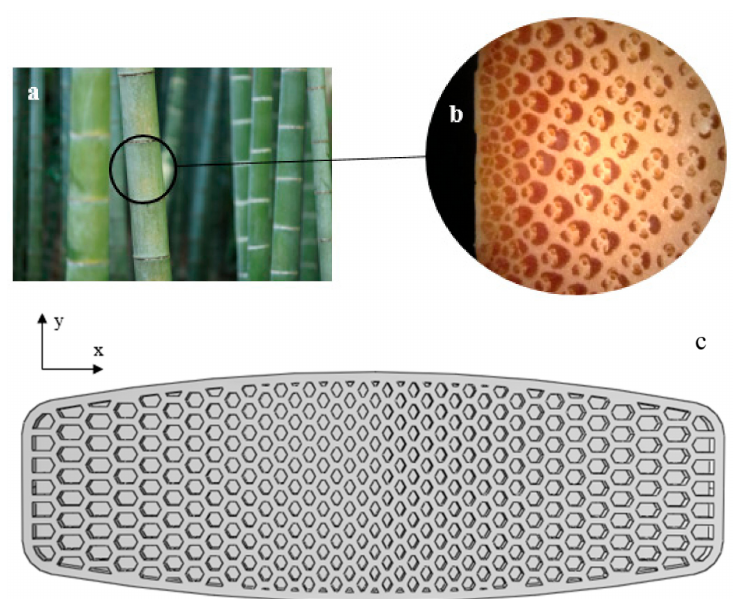
Figure 20. ( a ) A Bamboo stalk; ( b ) An optical image of the FG bamboo cross-section in which the dark areas are the fibers, while the light areas are the parenchyma matrices (adapted from [34]); ( c ) Graded honeycomb structure applied to the core of the board.